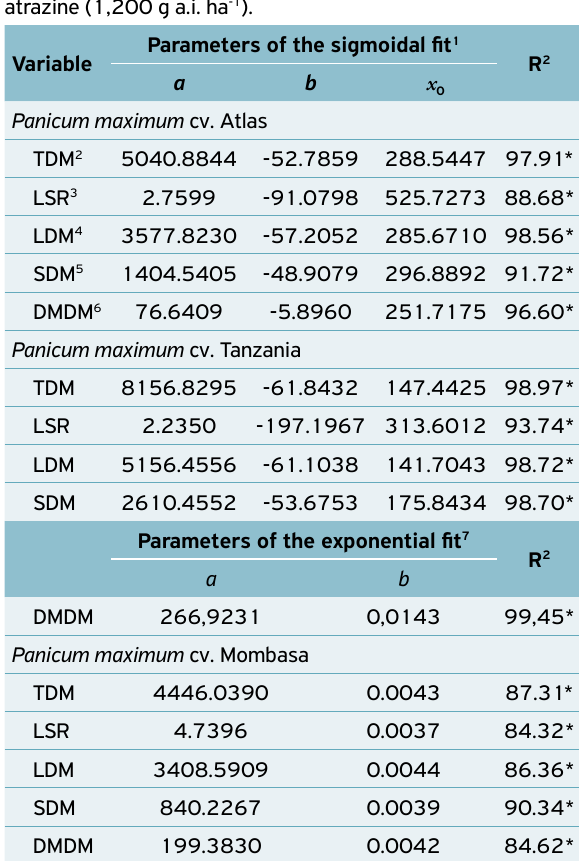
Table 3. Parameters of the regression equations obtained by fitting the sigmoidal model and coefficient of determination (R 2 ) applied to the means of total dry matter (kg ha -1 ), leaf to stem ratio, leaf dry matter (kg ha -1 ), stem dry matter (kg ha 1 ), and dead material dry matter (kg ha -1 ) in the cultivation of Panicum maximum cv. Atlas, P. maximum cv. Tanzania, and